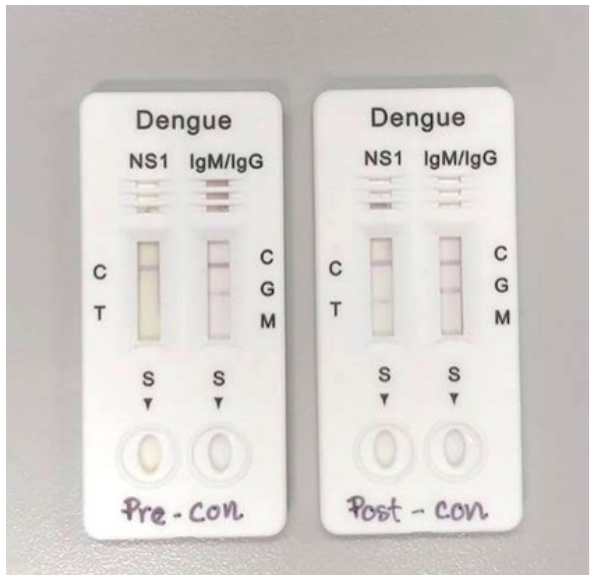
Figure 1. Example of RDT Pre-concentration and Post-concentration results.